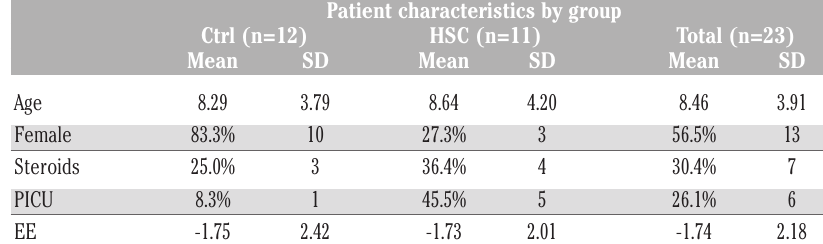
Table 1. Demographic description of wait-list control and therapy groups.